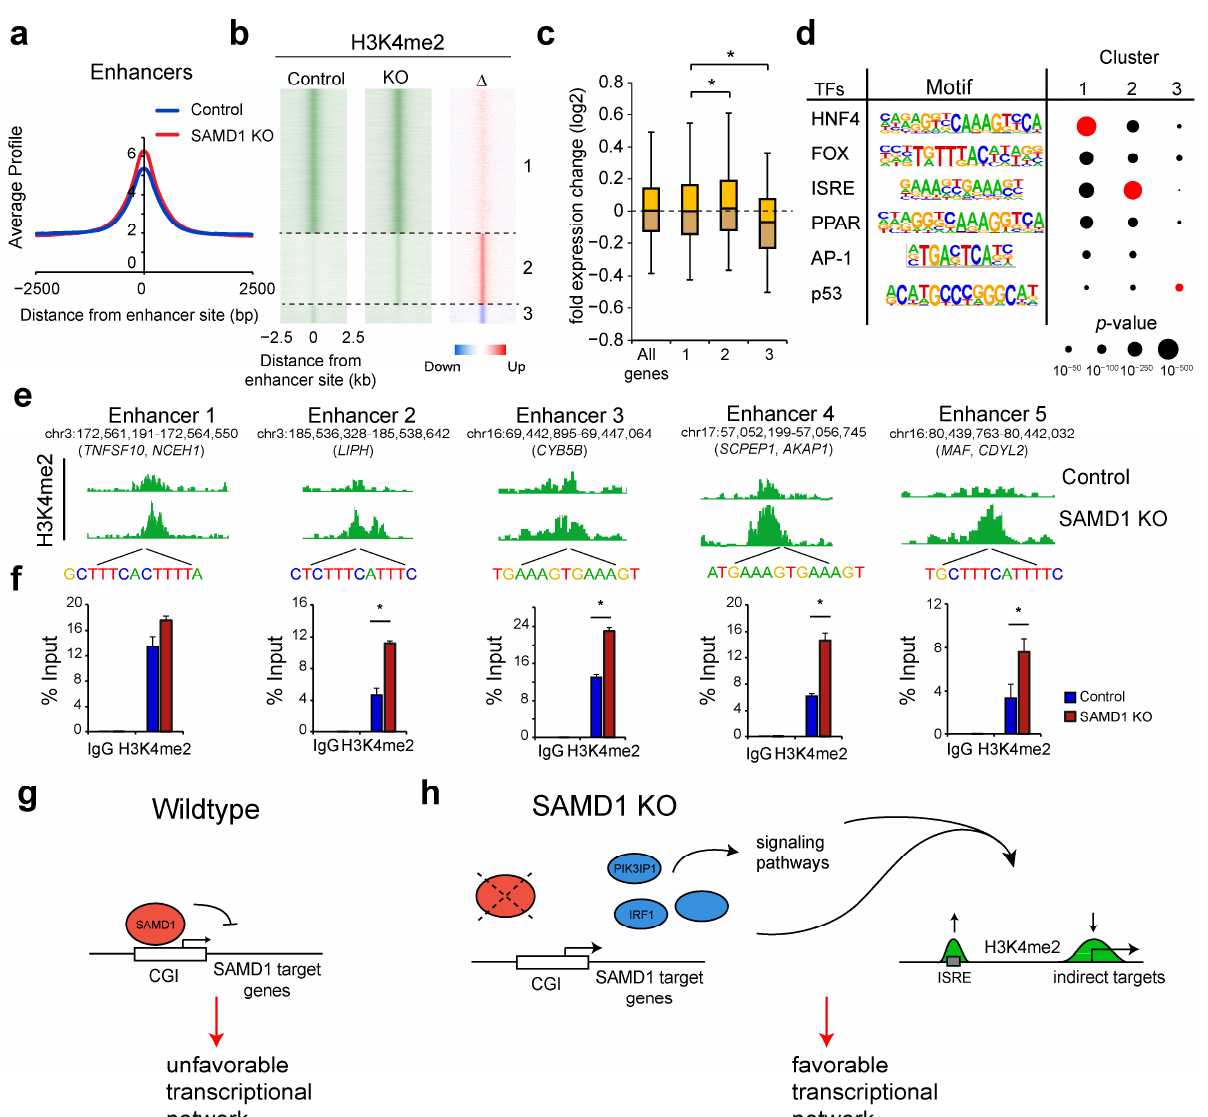
Figure 6. SAMD1 deletion leads to increased H3K4me2 levels on a subset of enhancers. ( a ) H3K4me2 ChIP-Seq profiles in control and SAMD1 KO cells at all enhancers. ( b ) Heatmap of H3K4me2 at enhancers. The difference is shown in the right plot. Three clusters were defined based on levels in control and knockout cells. (group 1: n = 49,133; 2: n = 23,960; 3: n = 6160) ( c ) Gene expression changes of the neighboring genes to the enhancers in each group, compared to all genes. Box plots represent upper and lower quartiles of the data with 5 and 95% whiskers. Signifi- cance was evaluated using ANOVA. * p < 0.01. ( d ) Motif analysis of the three clusters from B. The motif that is most strongly enriched in each cluster is marked red. ( e ) H3K4me2 ChIP-Seq data at example enhancers with increased H3K4me2 after SAMD1 deletion. ( f ) ChIP-qPCR of H3K4me2 at these enhancers in control and SAMD1 KO cells. Error bars indicate the SD of two technical repli- cates. * p < 0.05 (Student’s t -test). ( g ) Model of SAMD1’s role in hepatocellular carcinoma cells. In wild-type HepG2 cells, SAMD1 binds to unmethylated CpG islands functioning as a transcrip- tional repressor and contributing to an unfavorable transcriptional network. ( h ) Upon SAMD1 deletion, SAMD1 target genes such as PIK3IP1 and IRF1 become derepressed, which affects signal- ing pathways and further downstream targets. This leads to a reduced H3K4me2 level at most promoters and an increase in H3K4me2 levels at enhancers related to the interferon response. To- gether, this establishes a more favorable transcriptional setup.